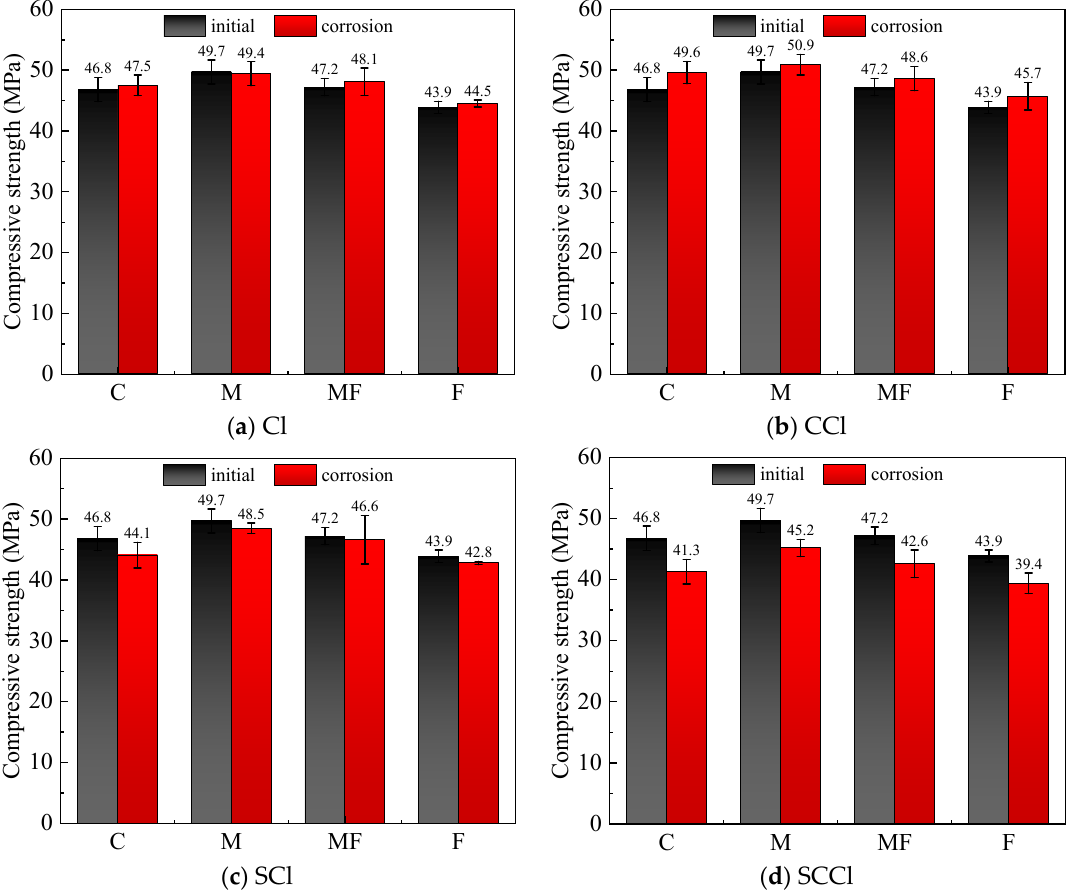
Figure 6. Variation in mortar strength under different erosion environments.